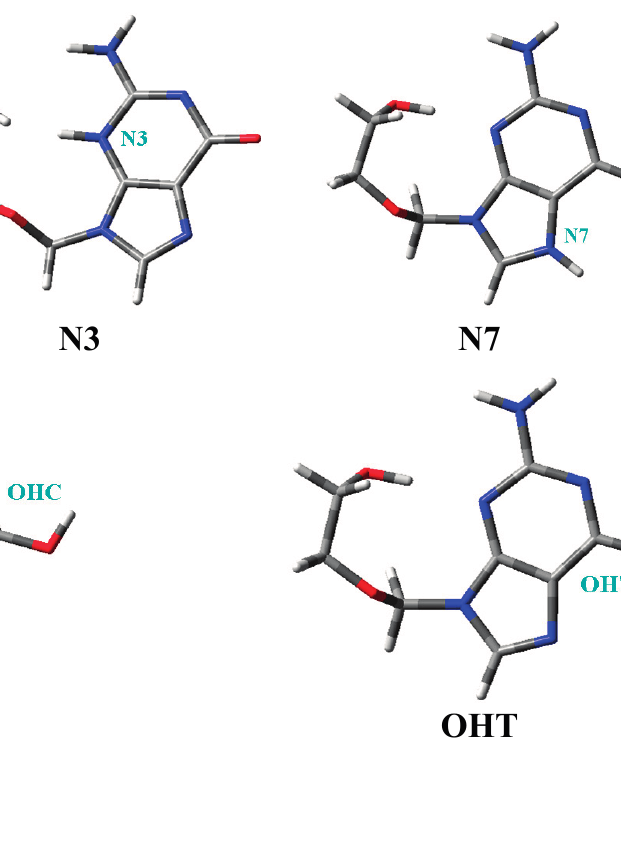
Figure 2. Five tautomers described in